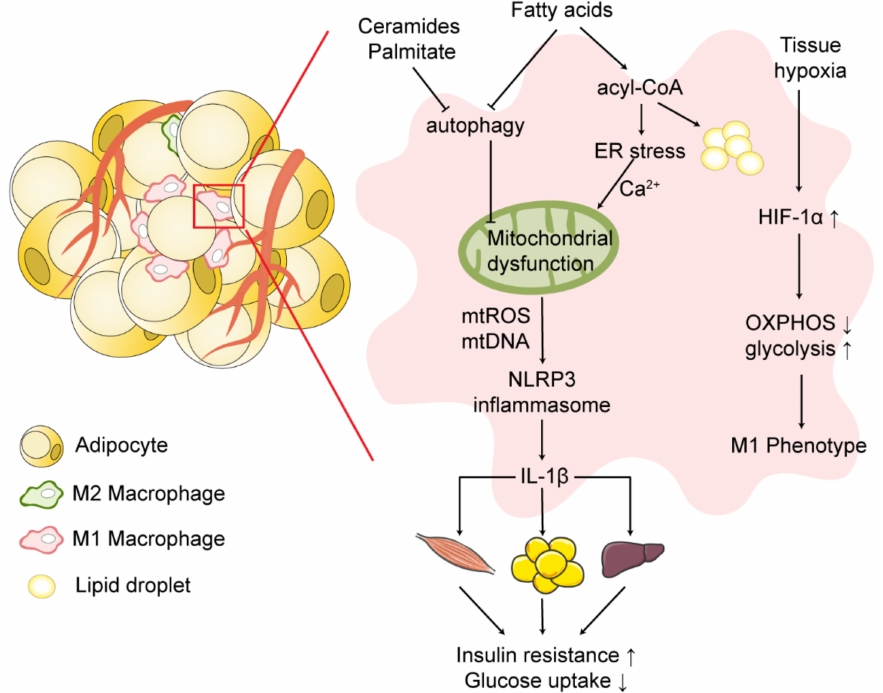
Figure 2. Mitochondrial dysfunction and NLRP3 inflammasome activation in obese adipose tissue. During obesity, the hypertrophy and hyperplasia of adipose tissue induce local tissue hypoxia and the infiltration of macrophages in adipose tissue. Under hypoxia, activated HIF-1 α shifts cellular energy metabolism from OXPHOS to glycolysis and induces the macrophage M1 phenotype. Excessive uptake of free fatty acids by adipose tissue macrophages shifts fatty acid utilization from OXPHOS to triglyceride, phospholipid, and ceramide synthesis, promoting lipotoxicity in macrophages. Fatty acids induce disruption of ER structure and ER stress, leading to mitochondrial calcium overload and mitochondrial dysfunction. Impaired autophagy induced by ceramides, palmitates and saturated fatty acids leads to the accumulation of dysfunctional mitochondria. Mitochondrial